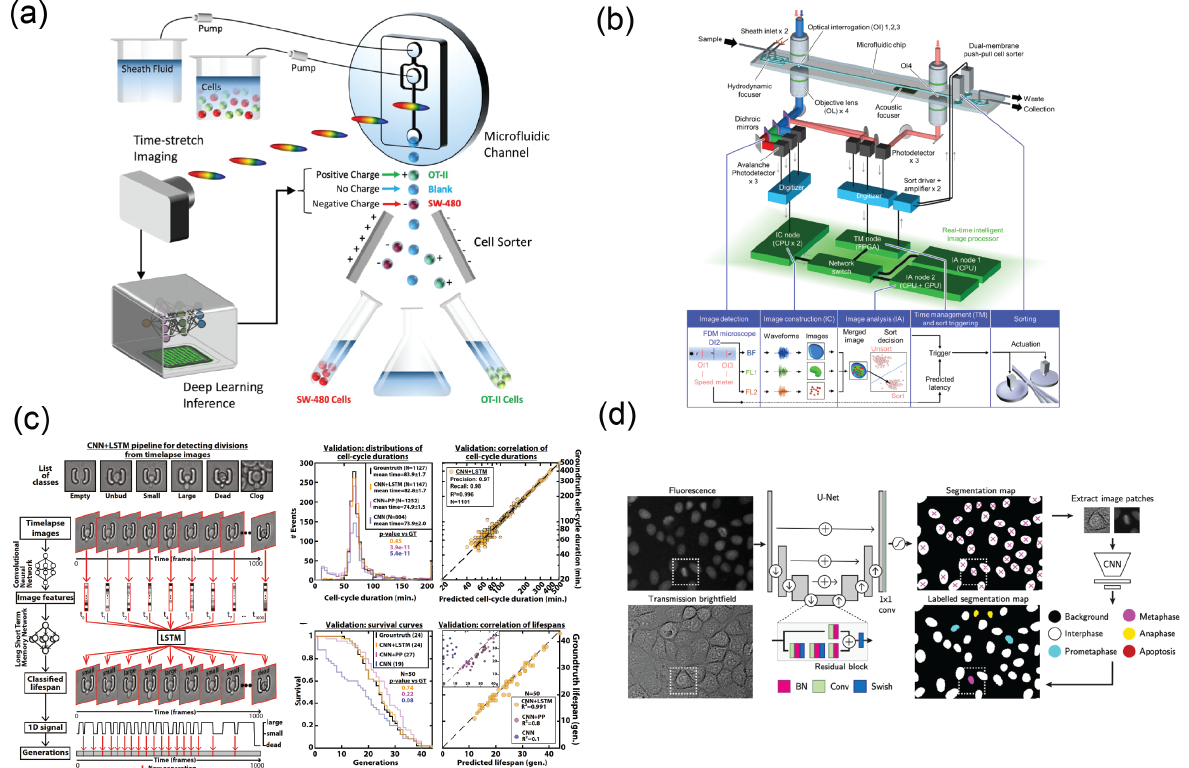
Figure 5. Microsystems integrated with AI for cell analysis. ( a ) An optofluidic time-stretch QPI cell sorter based on high-speed, label-free cell classification and sorting empowered by deep learning [213]. Reproduced under CC–BY license. ( b ) Frequency-multiplexed microscopy coupled with real-time ma- chine learning processing and piezoelectric actuator for high-speed cell sorting. Reprinted from [226] with permission from Elsevier. ( c ) A microfluidic cell trap with AI phenotype prediction for yeast division tracking and survival analysis [250]. Reproduced under CC–BY license. ( d ) A deep learning framework to automatically classify cell cycles and track lineage trees [265]. Reproduced under CC–BY